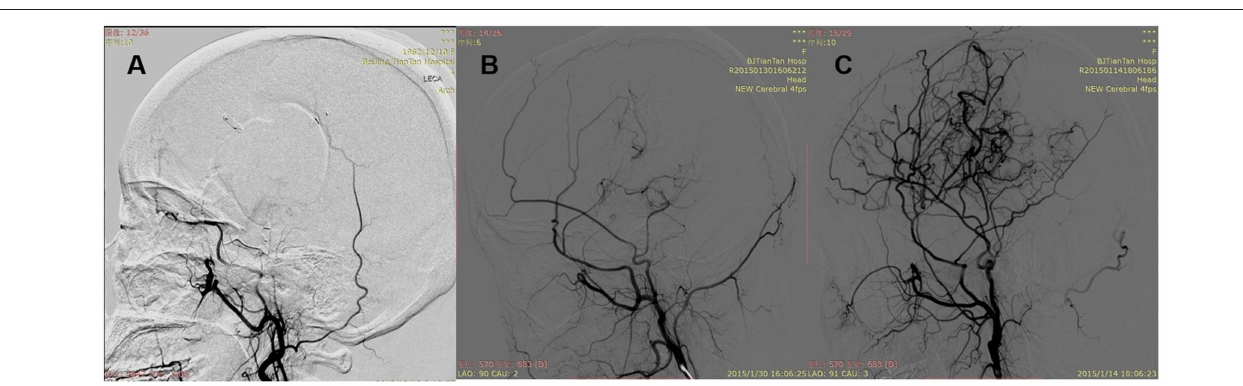
FIGURE 2 | Patency of the anastomosis. (A) Occluded: complete proximal occlusion of STA and disappearance of MCA branches. (B) Stenosed: thin and stenosed STA with a few visible MCA branches. (C) Patent: patent or dilated STA with patent or even dilated MCA